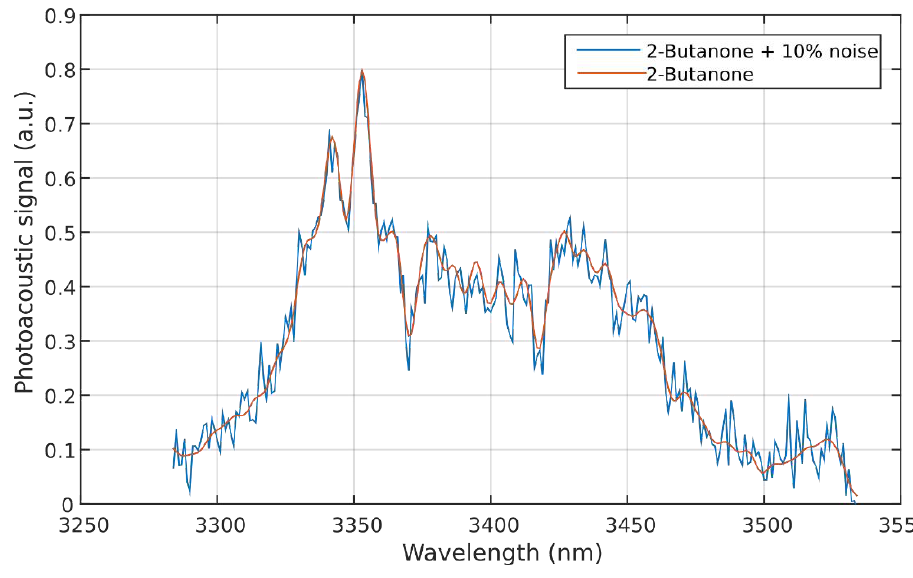
Figure 3. Spectra of 2-butanone with and without additional noise.